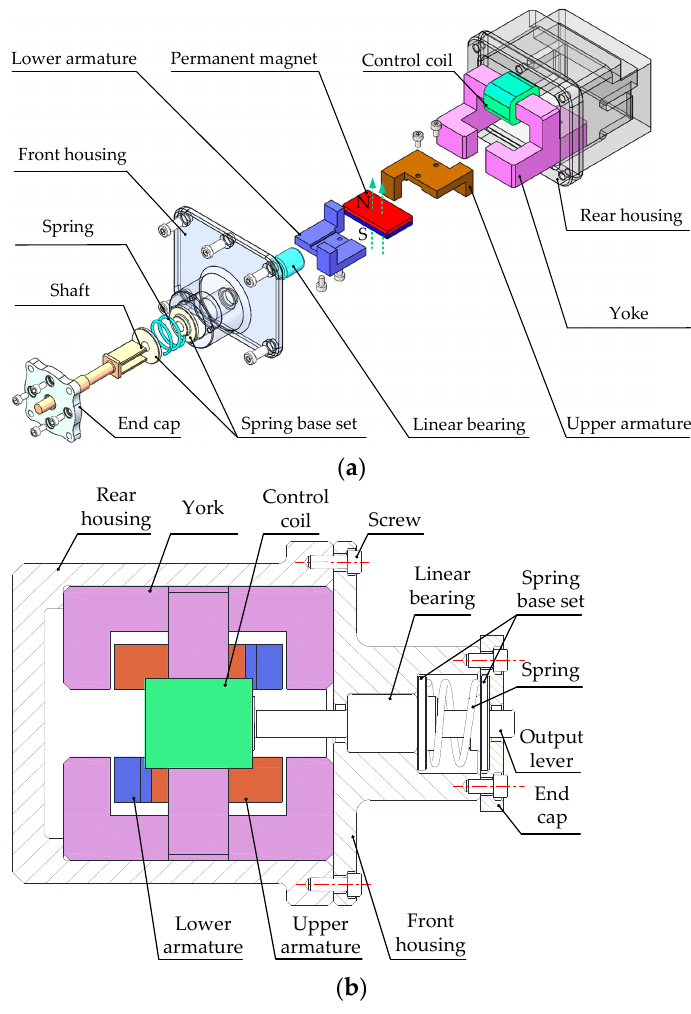
Figure 3. The structural configuration of the NLFM. ( a ) A blow-up view of 3D parts; ( b ) the 2D section